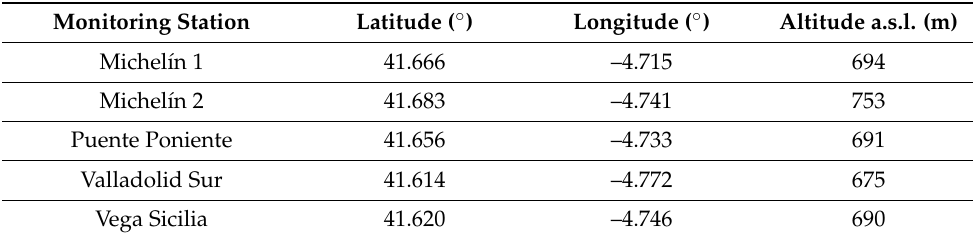
Figure 1. Location of the measuring stations in Valladolid (Castilla y León, Spain) (Image courtesy of Valladolid Council). Table 1. Main features of the monitoring